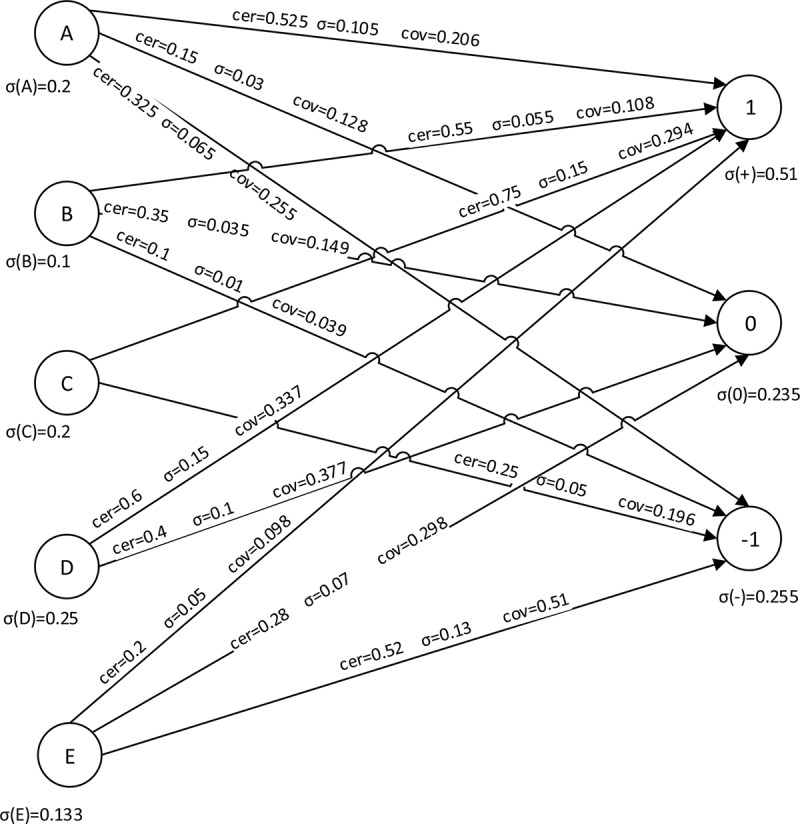
Flow graph for Table 8.